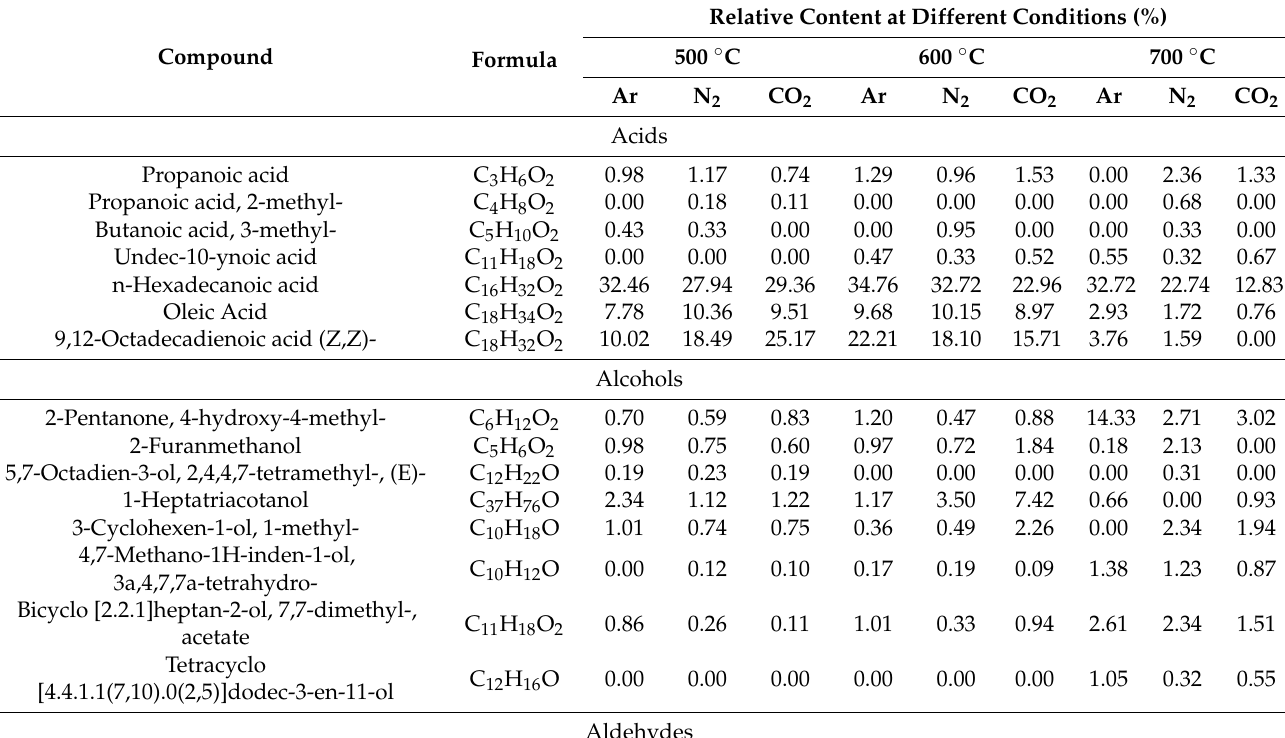
Table 4. Chemical compositions of the oils obtained under argon, nitrogen, and carbon